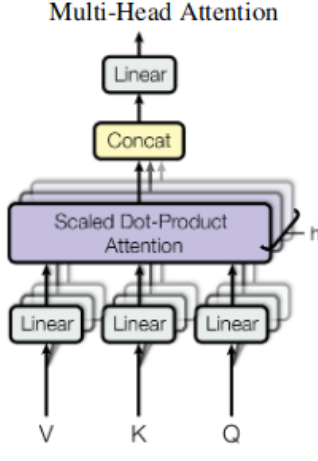
Figure 5. Multi-head Attention